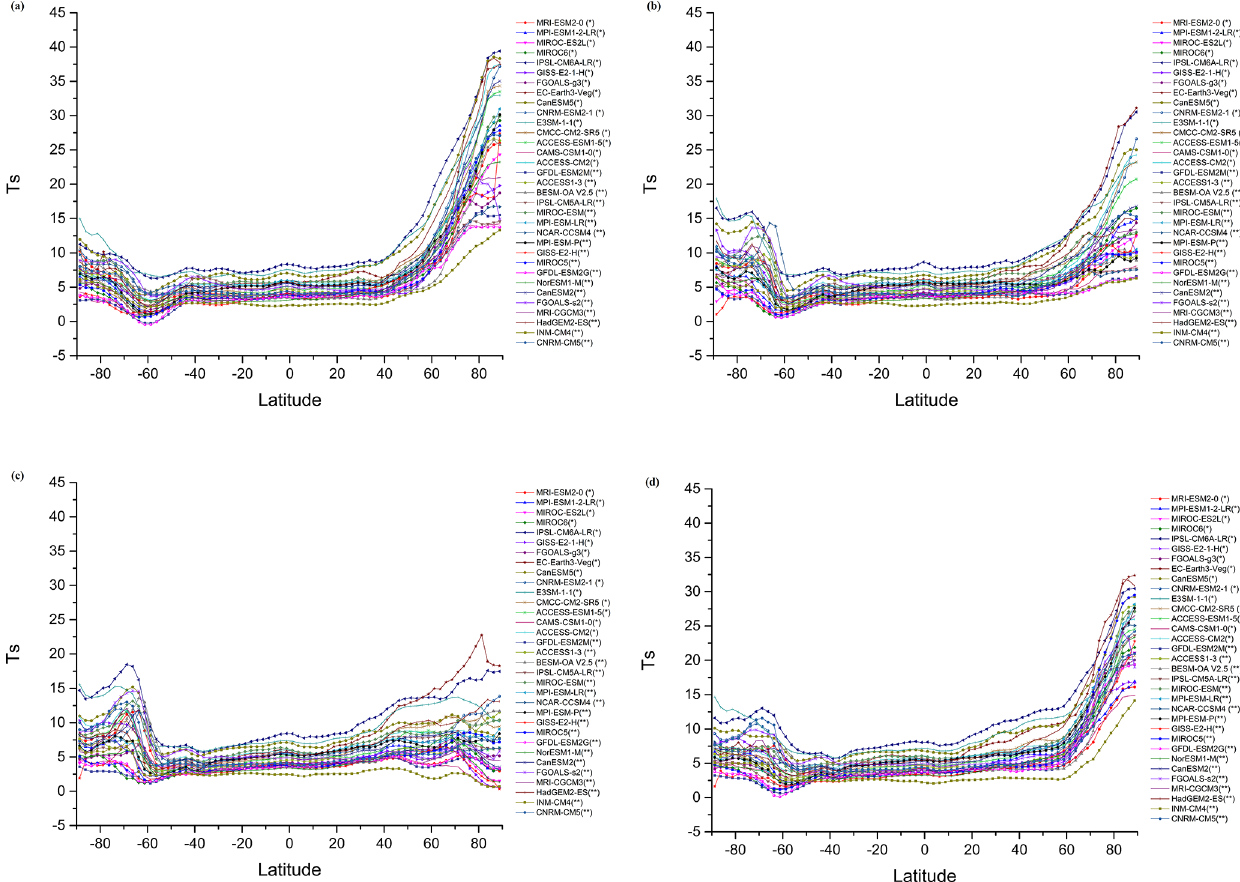
Figure 2. Seasonal zonal mean surface temperature differences ( K ) for the last 30 years of the Abrupt-4 × CO 2 numerical experiment minus the last 30 years of the piControl run for the CMIP5 and CMIP6 models for (a) winter (DJF), (b) spring (MAM), (c) summer (JJA) and (d) fall